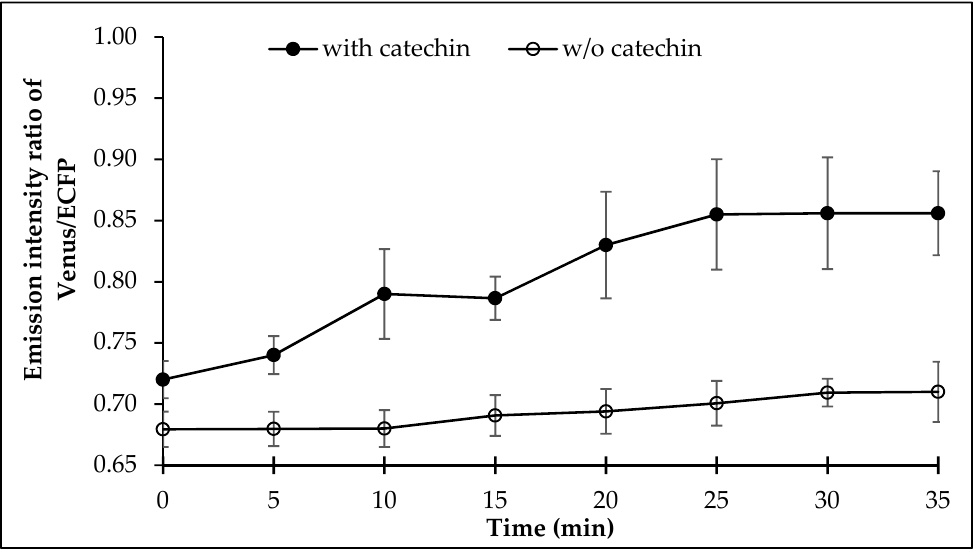
Figure 5. Dynamics of ( + )-catechin levels in live bacterial cell. Values are means of three independent replicates. Vertical bar indicates standard error.